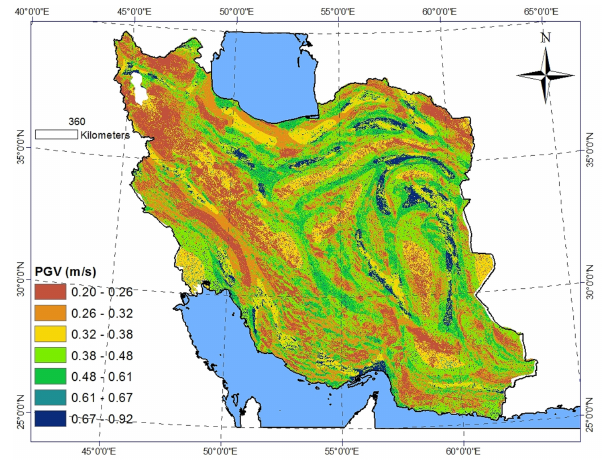
Table 4. Threshold ground acceleration PGA( t ) (FEMA,